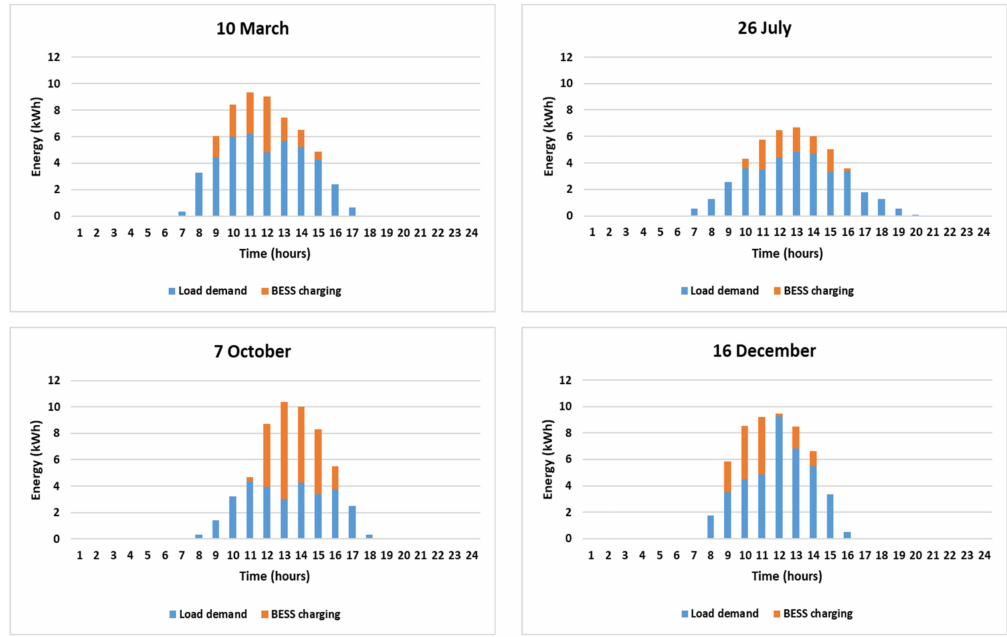
Figure 7. Distribution of PV production of each simulated day for scenario A.